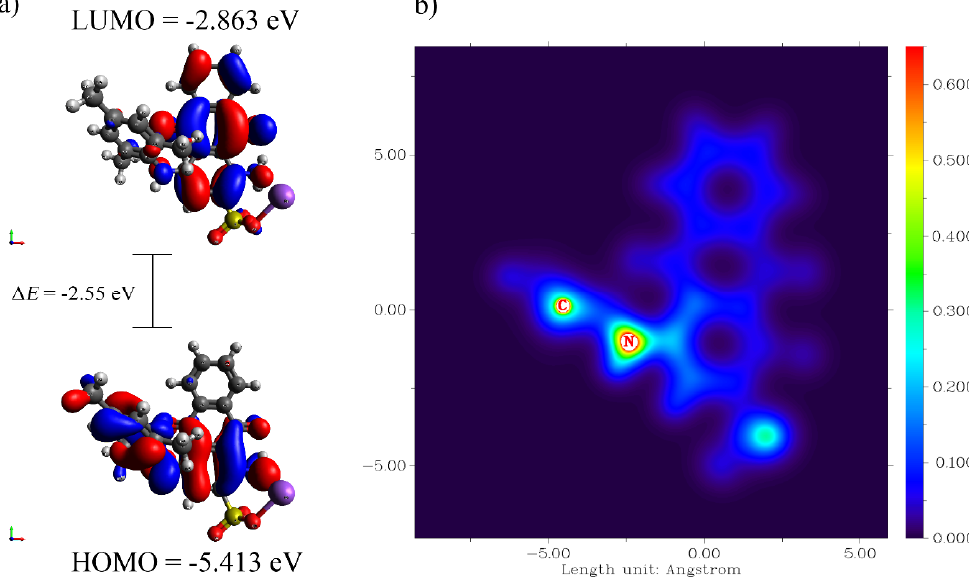
Figure 6. ( a ) HOMO and LUMO of AB129 obtained at B3LYP / 6-31G** and ( b ) map of the electron density (X, Y plane) of AB129 molecule (the sodium atom was removed for simplicity).